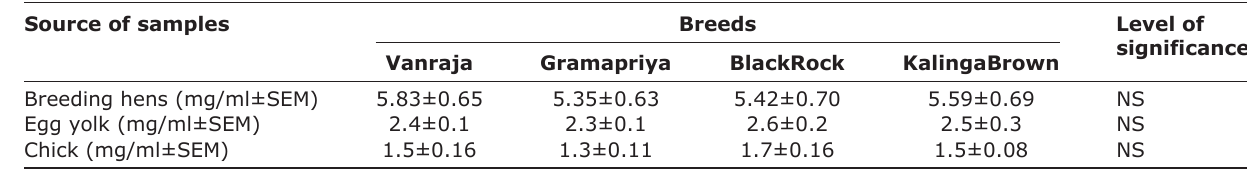
Table-3: IgY levels in breeding hens, egg yolk and chicks in four different breeds of poultry. Source of samples